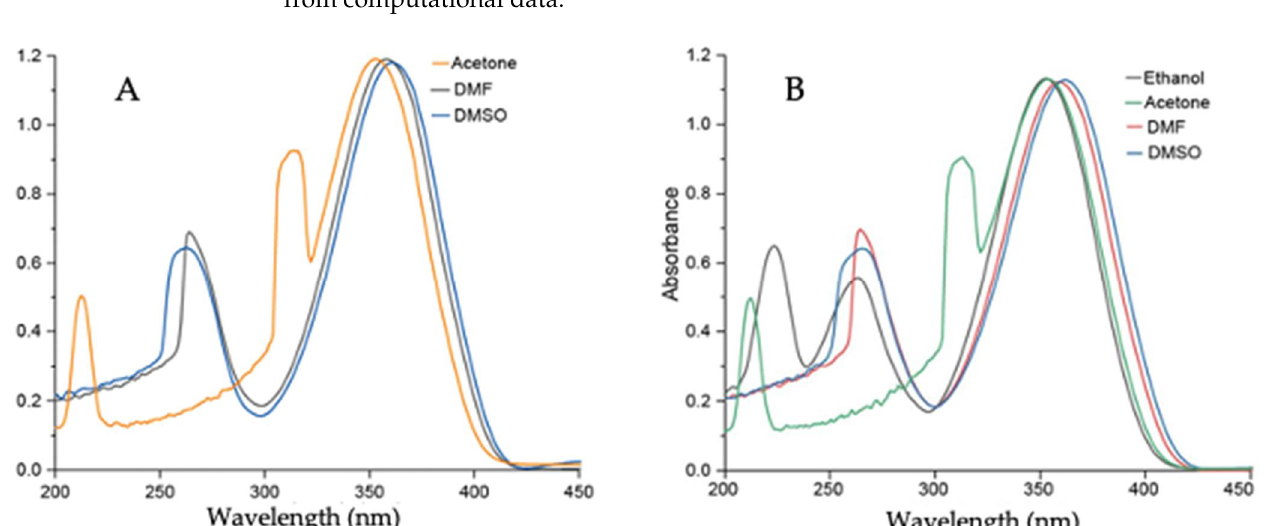
Figure 9. UV–vis spectrum of ( A ) Comp3 (0.5 × 10 −5 M) in DMF and DMSO; ( B ) Comp4 (0.5 × 10 −5 M) in acetone, ethanol, DMF, and DMSO. 3.5.2. Thin Film Preparation The synthesized compounds Comp1, Comp4, Comp2, and Comp3 were separately dissolved in chloroform and DMSO to obtain 5 × 10 −2 M solutions of the compounds. The prepared solutions were individually dropped onto a precleaned FTO glass substrate. The substrate was then placed on the spin coater (Holmarc, Model no-HO-TH-05) and rotated at 1000 rpm for 30 s. This process was repeated three times to achieve a uniform film on the substrate. The spin-coated film was then annealed at 70 °C in an oven. In addition, silver contact was provided by applying silver paste on top of the film to fabricate a device in a sandwich-like fashion (FTO- Comp -Ag). We also used Al contact for HIE and EIE measurements of the compounds.